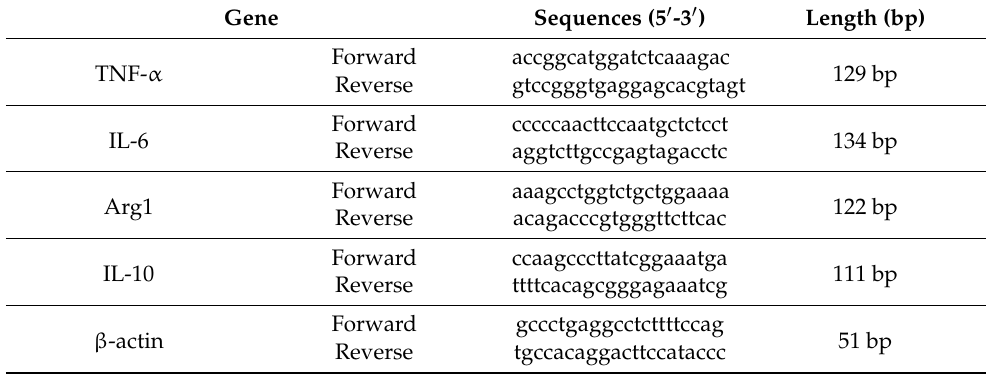
Table 1. Primer sequences for quantitative real-time polymerase chain reaction.